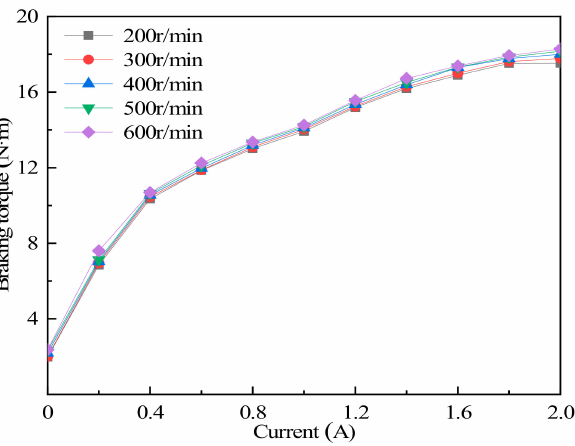
Figure 13. Variation of experimental braking torque with current and rotational